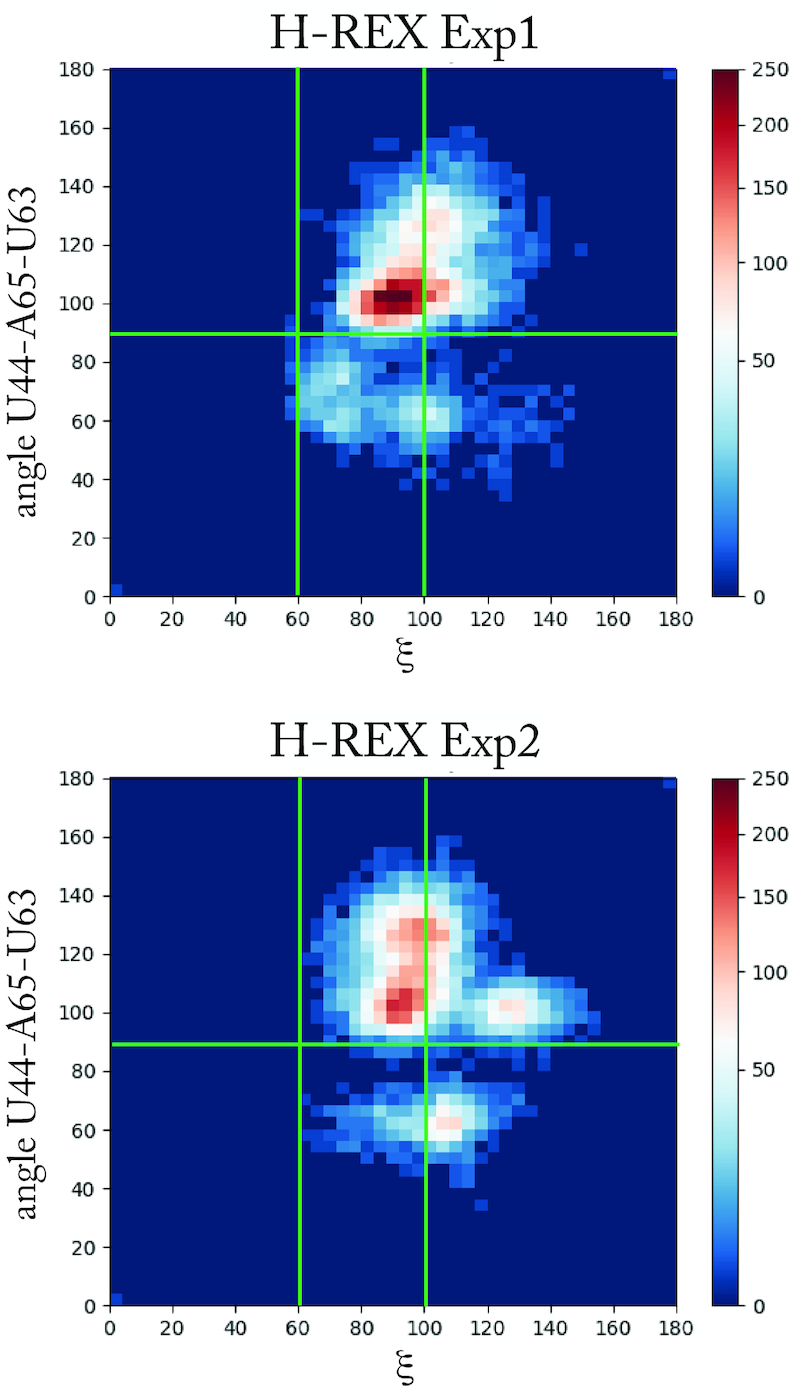
Projection of the structures sampled by H-REX onto the variable ξ, indicating the family to which the structure belongs, and the angle U44–A65–U33, indicating the inward or outward position of U63. A similar plot for the path sampling results is provided in Supplementary Figure S3.